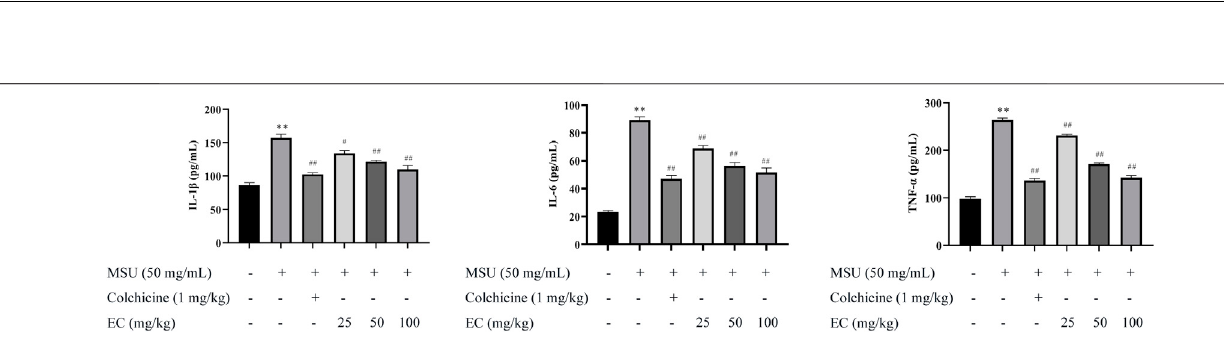
FIGURE 6 | Effect of EC on IL-1 β , IL-6, and TNF- α expressions in ankle joint tissues of MSU-induced acute gouty arthritis mice. Mice were intragastrically administrated with different doses of EC consecutively for 7 days, followed by MSU (0.025 ml MSU suspension with 50 mg/ml) injection into the ankle 1 h after EC administration on the sixthday. Theankle joint 24 h after MSU injection was grinded withliquid nitrogen, and theratio ofankle jointpowder tonormal saline was1:10 (g/ ml). The supernatant is used for detection. Data are represented as mean ± SEM of ten mice per group. ** p < 0.01 compared with the control group; # p < 0.05 or ## p < 0.01 compared with the MSU